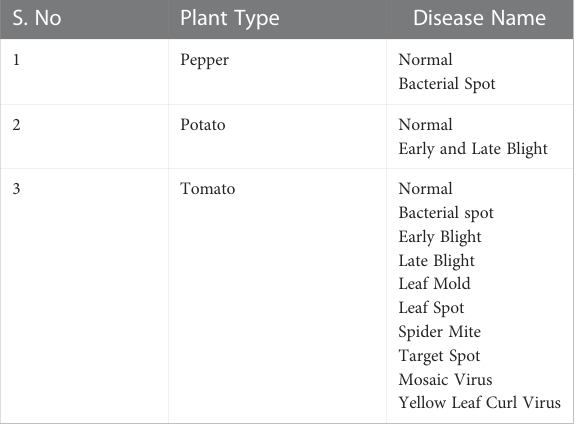
TABLE 1 PlantVillage Benchmark dataset